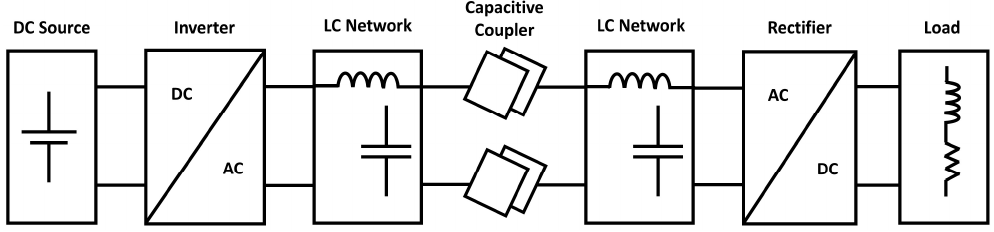
Figure 11. Architectural diagram of a capacitive WPT system [16].